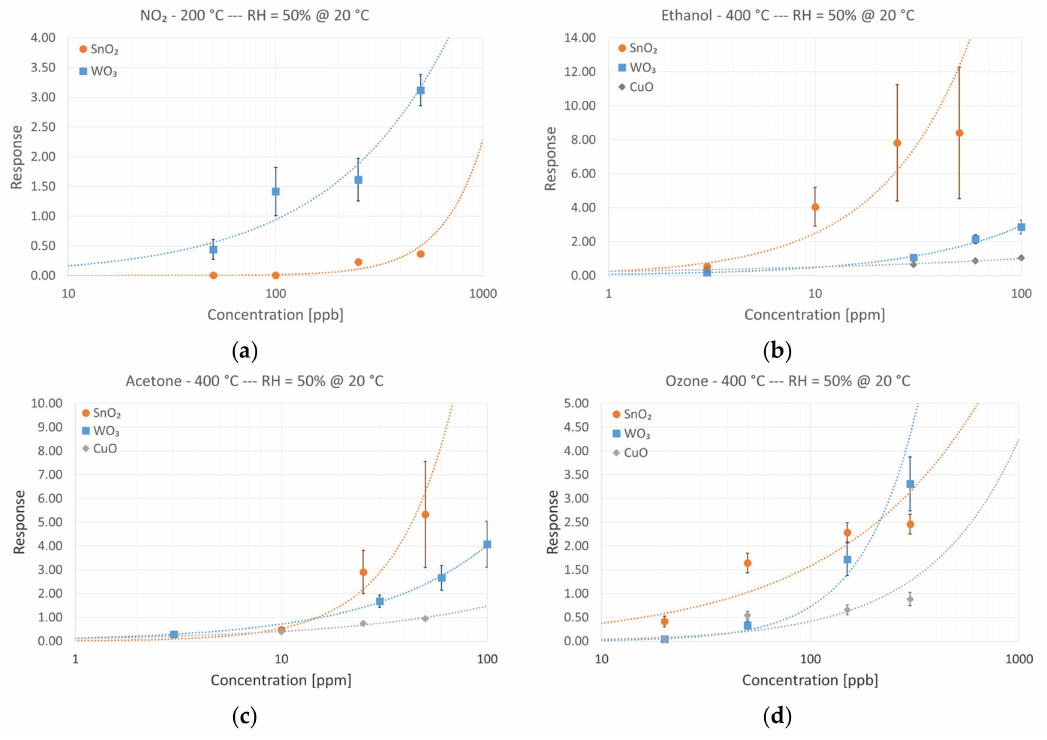
Figure 8. Calibration curves in the presence of di ff erent chemical species: ( a ) NO 2 , ( b ) ethanol, ( c ) acetone, and ( d ) ozone. Relative humidity was 50% at 20 ◦ C.